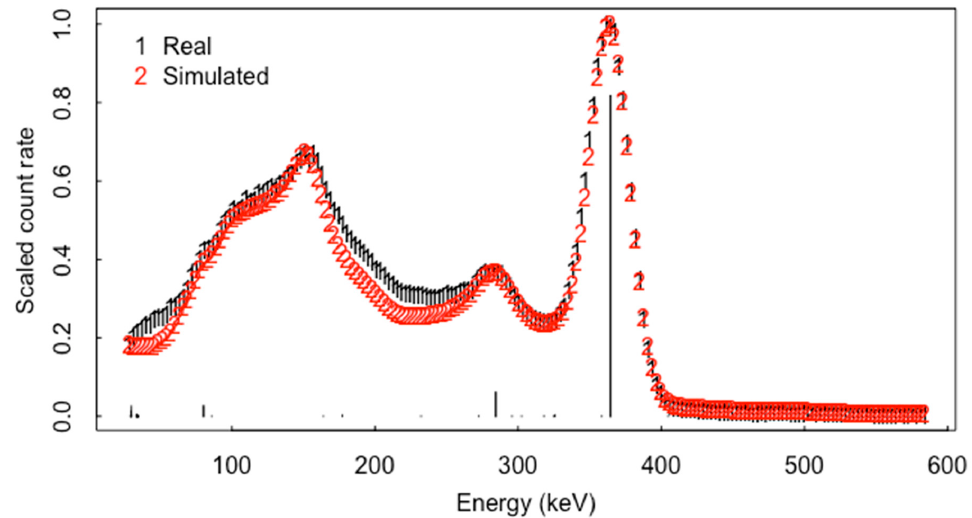
Figure 1. Simulated and real (smoothed) I-131 spectral data.